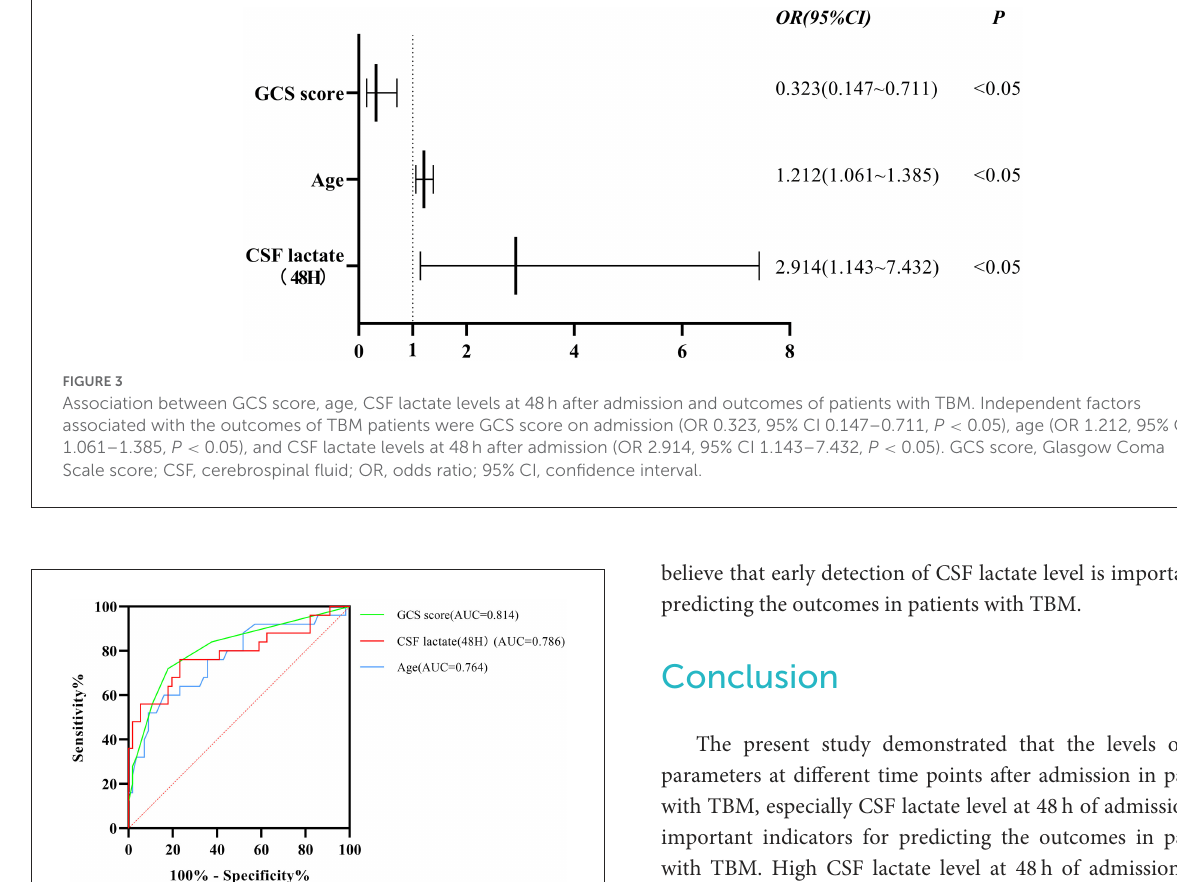
FIGURE4 Receiver operating characteristic (ROC) curve analysis shows the accuracy of GCS score, age, and CSF lactate levels at 48h after admission in predicting prognostic outcomes of patients with TBM. GCS score, Glasgow Coma Scale score; AUC, area under the ROC curve; CSF, cerebrospinal